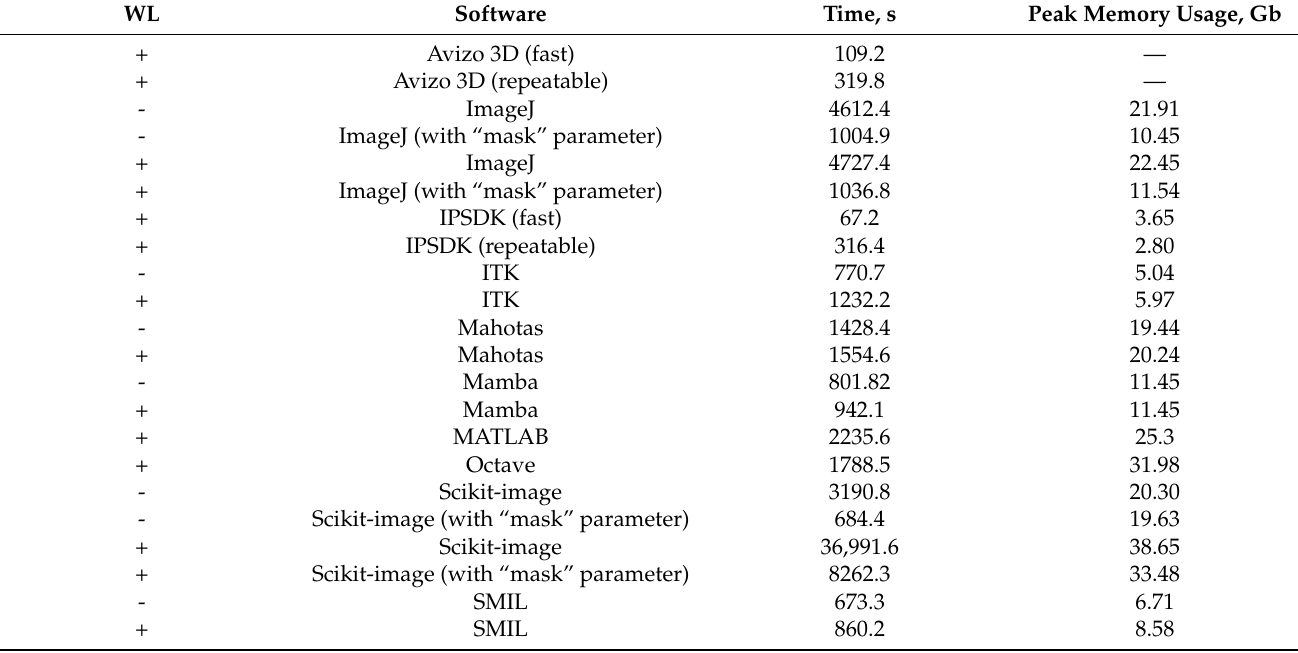
Table 6. Processing time and peak memory consumption of various watershed implementations for segmentation of distance map of micro-CT